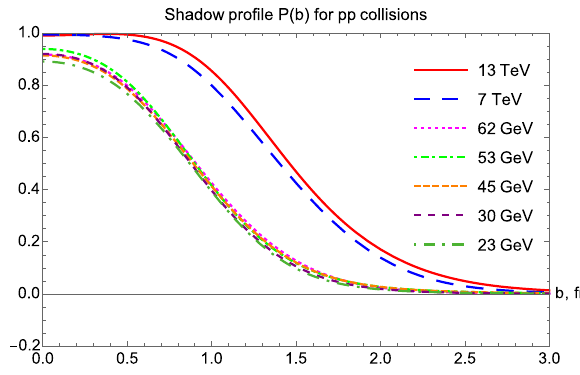
Fig. 8 Shadow profile functions for pp collisions from GeV to 13